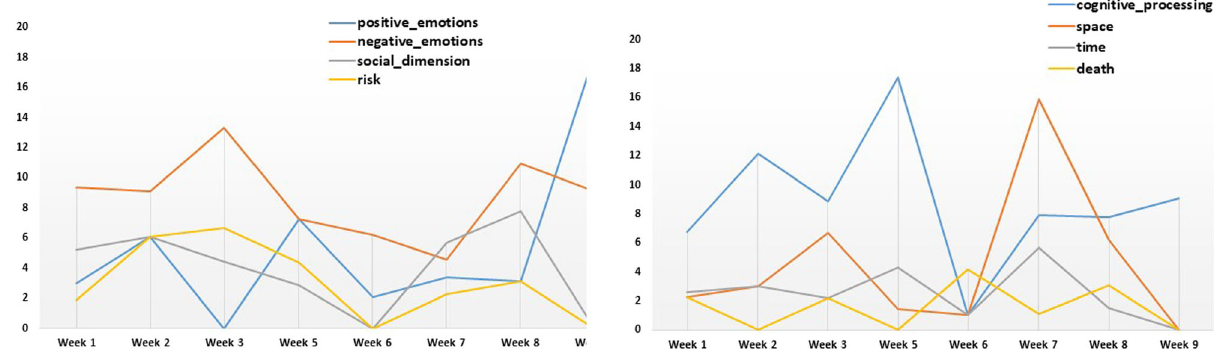
Fig. 5 Sentiment and cognitive categories of the words. Evolution of the per cent of words associated with valence, social dimension, and risk over the weeks in the left panel; and with cognitive processing, space, time, and death in the right panel.